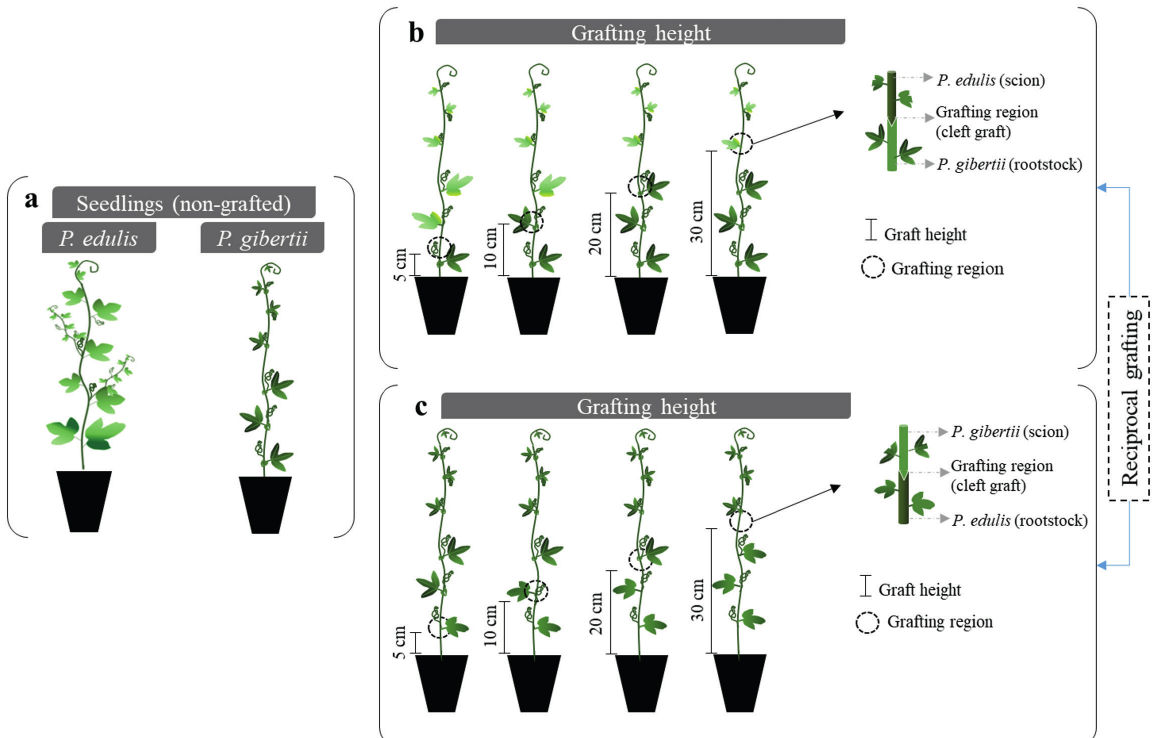
Figure 1 - ( a ) Non-grafted P. edulis and P. gibertii plants used as controls ( b ) grafting of P. edulis/P. gibertii at four grafting heights and ( c ) their reciprocal grafting of P. gibertii/P. edulis